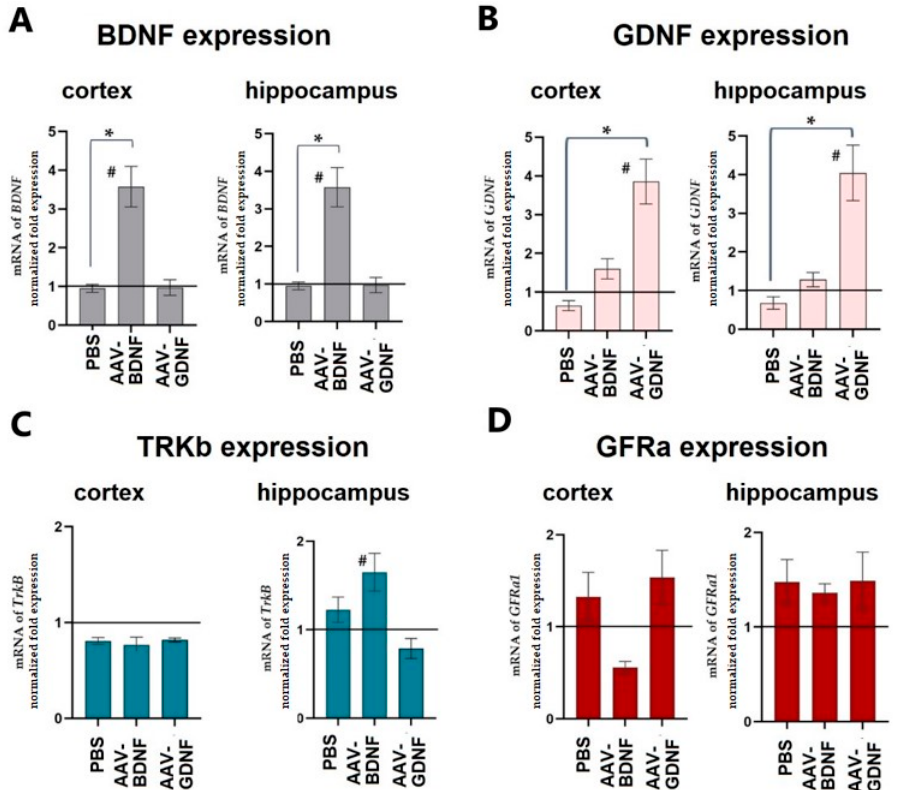
Figure 2. Expression levels of the neurotrophic factors BDNF ( A ), GDNF ( B ) and their receptors– TRKb ( C ) and GFRa ( D ), in the tissues of the cerebral cortex and hippocampus on day 30 after viral transduction (P30). Data were normalized relative to intact animals. #—statistically significant difference compared to the“PBS” group), *—statistically significant difference between experimental groups, p ≤ 0.05 (one-way ANOVA and Tukey’s multiple post-hoc test).